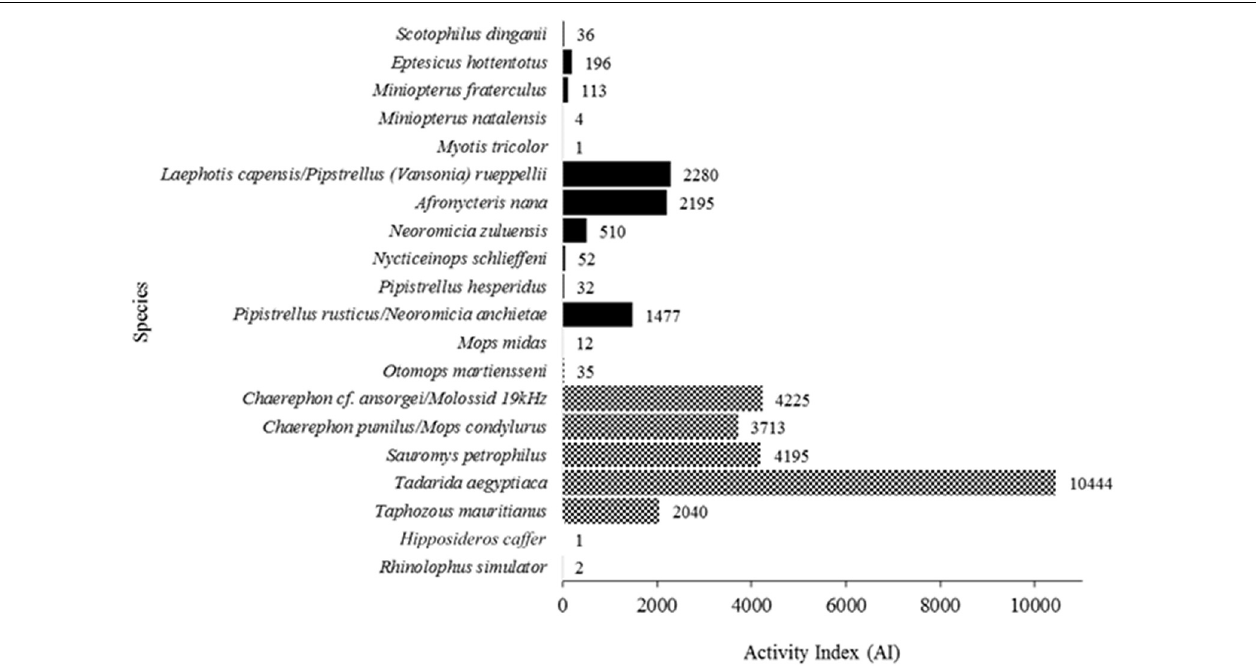
FIGURE 2 | Species identified with the associated sum of behavioural AI categories. Solid filled bars indicate clutter-edge foragers and the checkered bars indicate open-air foragers. Rhinolophus simulator and Hipposideros caffer are clutter foragers but were represented in such low numbers that a fill is not visible.